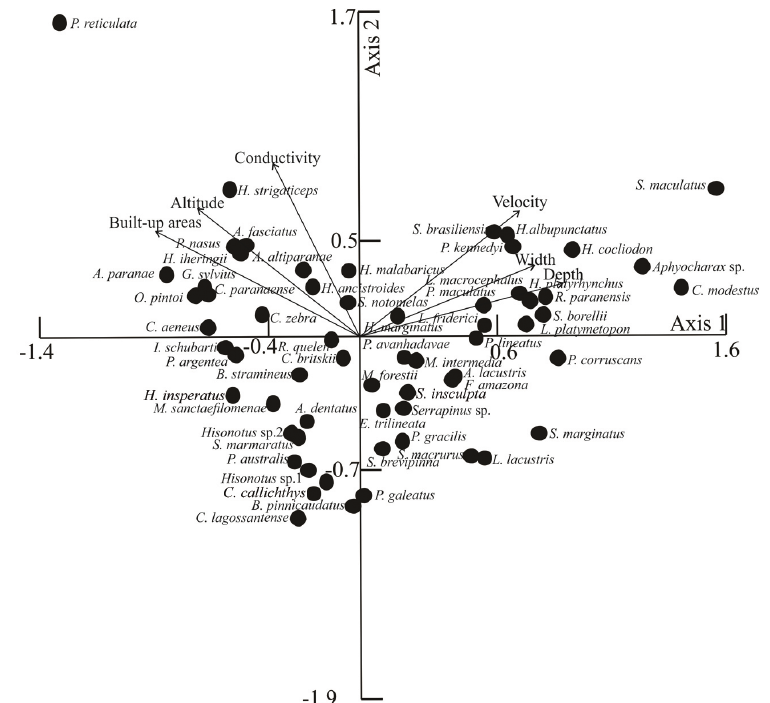
Figure 6. Scatter plot of distribution of fish species in the Ivinhema River basin, Upper Paraná River, from 2001 to